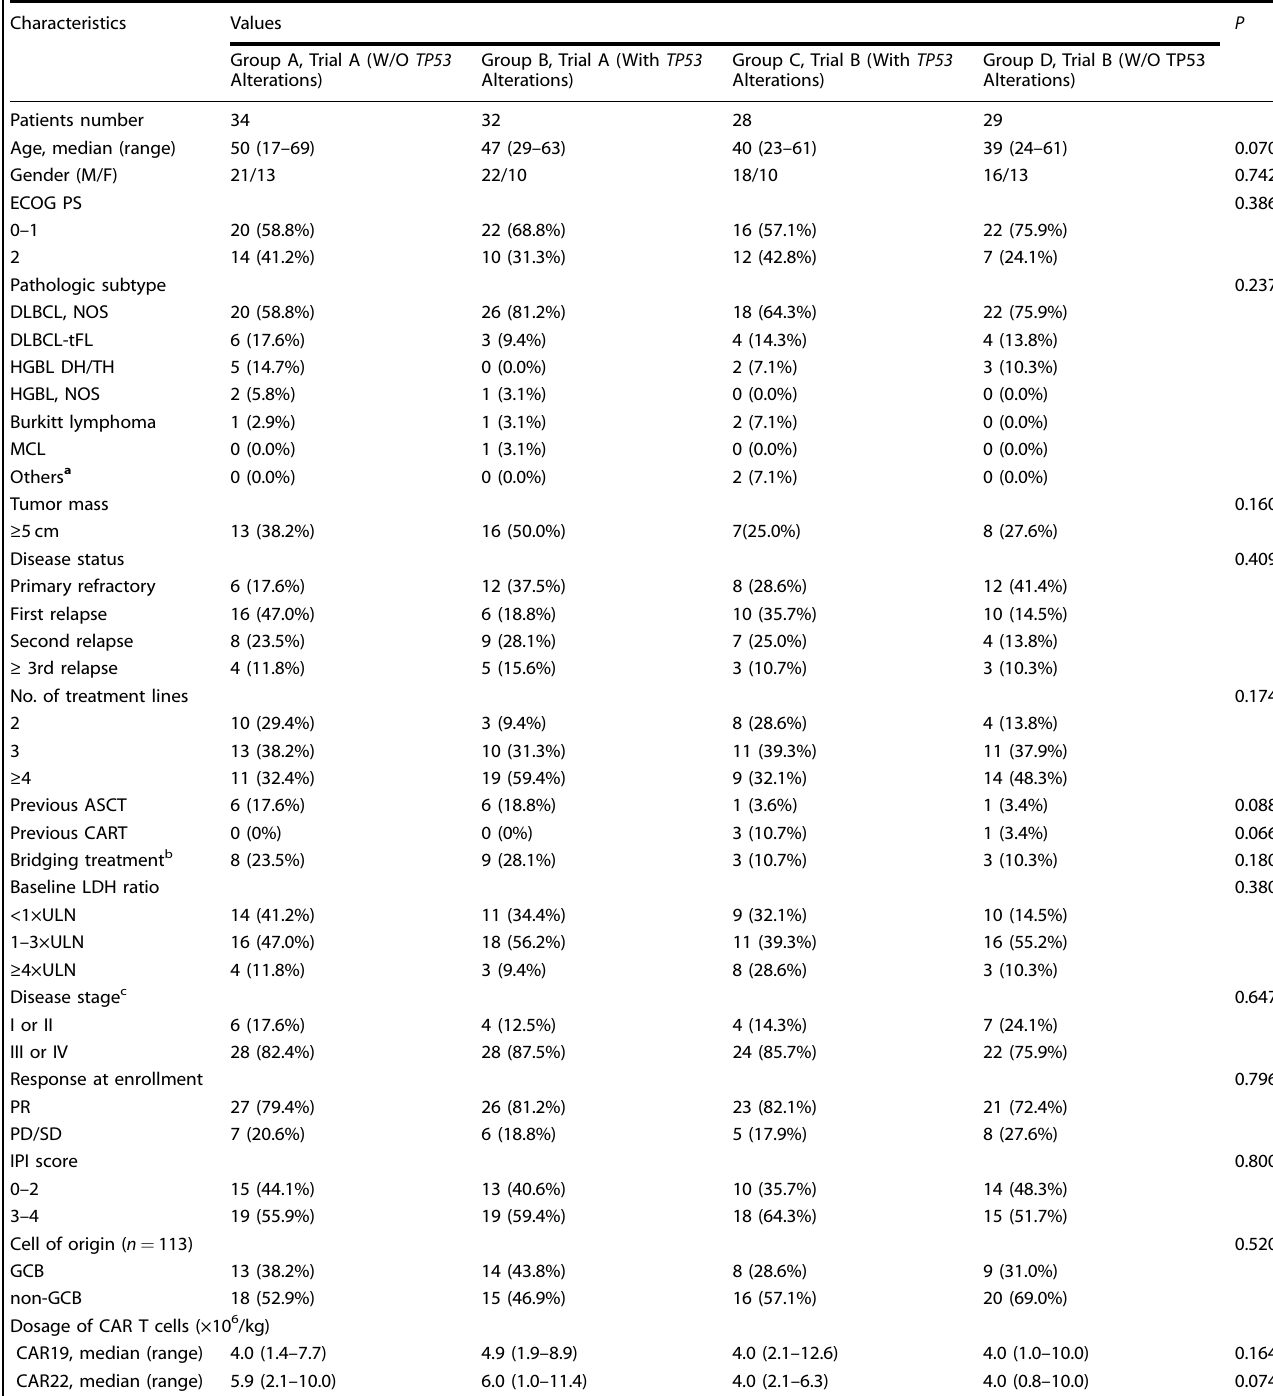
Table 1. Patients ’